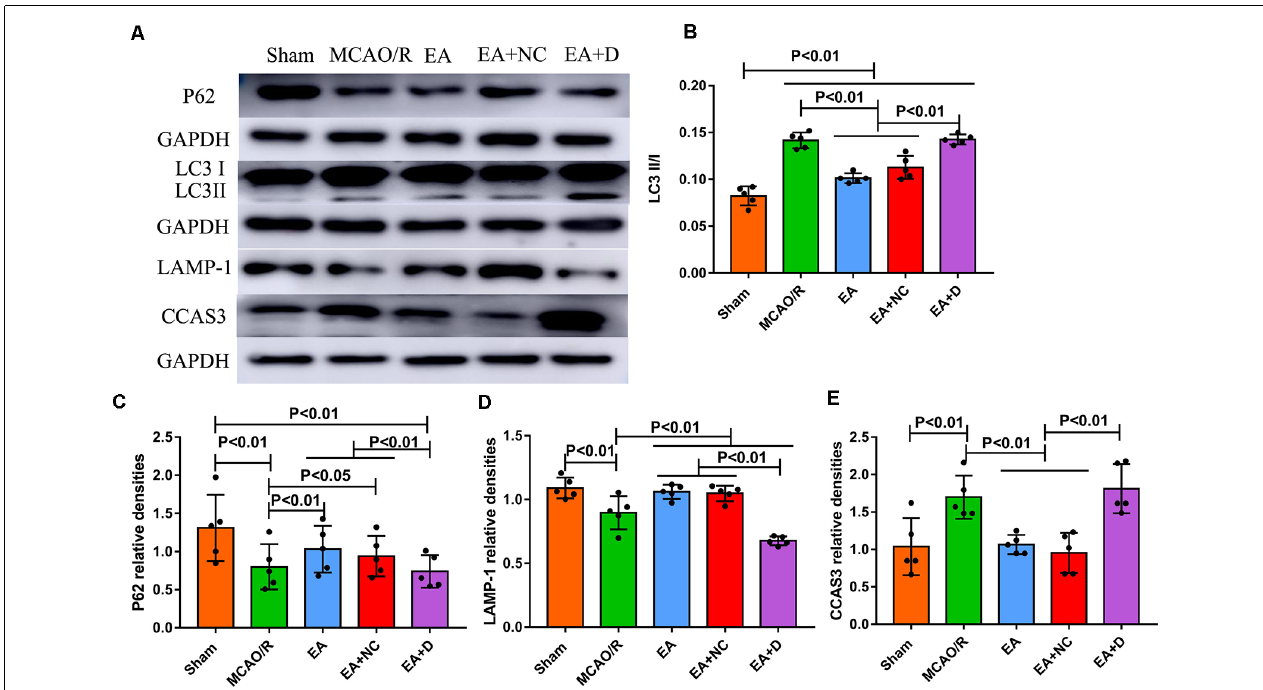
FIGURE 2 | Effect of electroacupuncture (EA) treatment on CCAS3 and autophagy-related proteins. (A) Western blot analysis of the expression levels of P62, LC3I, LC3II, LAMP-1, and CCAS3. (B) Bar diagram shows the difference of LC3II/I in the ipsilateral hippocampus of the rats ( n = 5/group). (C) Statistical analysis showing the expression of P62 in the ipsilateral hippocampus of the rats. (D) Statistical analysis showing the difference of LAMP-1 in the ipsilateral hippocampus of the rats. (E) Statistical analysis showing the expression of CCAS3 in the ipsilateral hippocampus of the rats.